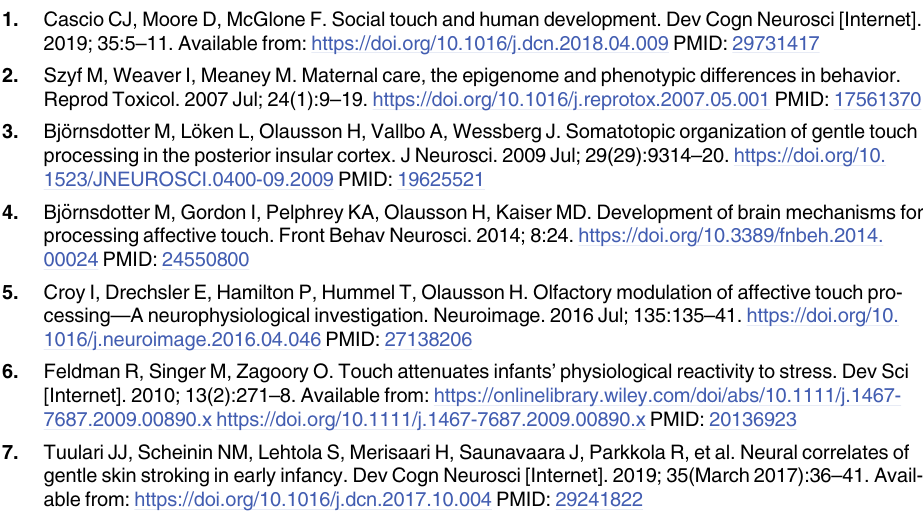
S3 Table. a. Fit indices obtained by imputing missing data with full information maximum likelihood approach (film) in the Calibration Sample. CFI = comparative fit index; NNFI = Tucker–Lewis index; RMSEA = root mean square error of approximation; SRMR = Standard- ized root mean square residual. TCD = total coefficient of determination. b. Factor loadings obtained with data imputation in the Calibration Sample. f1 = Childhood/Adolescent Touch Experience; f2 = Comfort with Interpersonal Touch; f3 = Fondness for Interpersonal Touch; f4 = Adult Touch Experience.